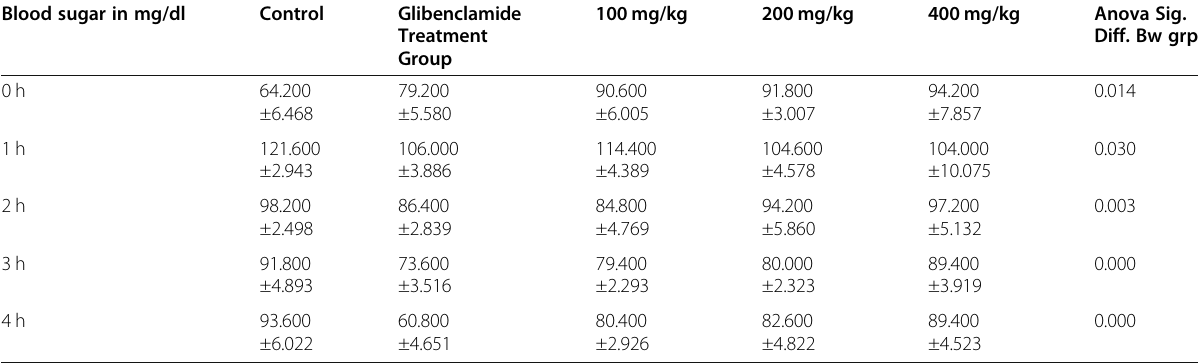
Table 5 Oral Glucose Tolerance Test (OGTT) in rats treated with A. inermis Extract Blood sugar in